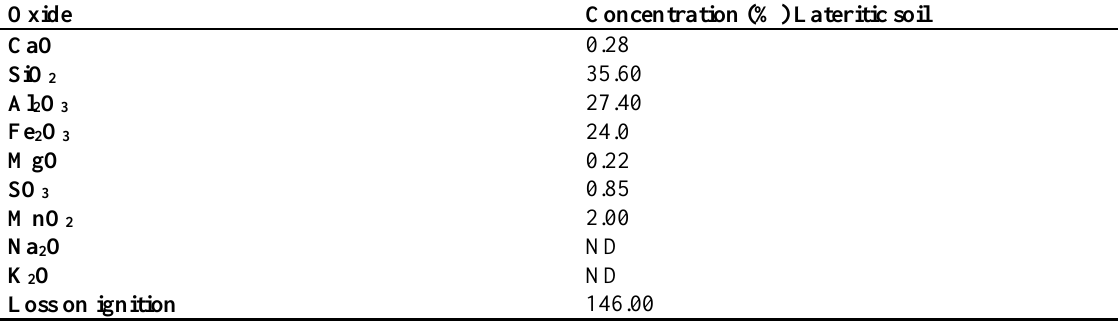
Oxide Composition of Lateritic